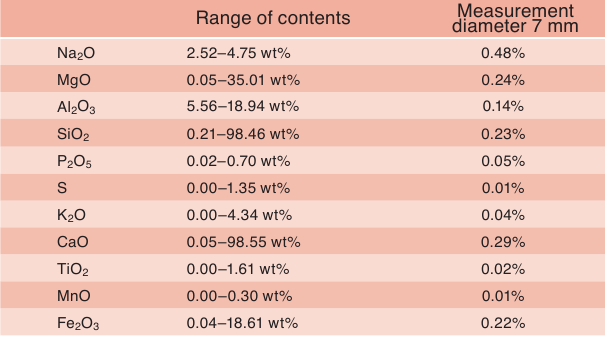
* For the accuracy test, repeated measurements of 11 standard samples produced by the Geological Survey of Japan have been used. Range of the contents represents the range of the standard sample for each element. The accuracy (absolute error) for a 7-mm measurement diameter is calculated as the standard deviation of the measurement versus the average of repeated measured values.